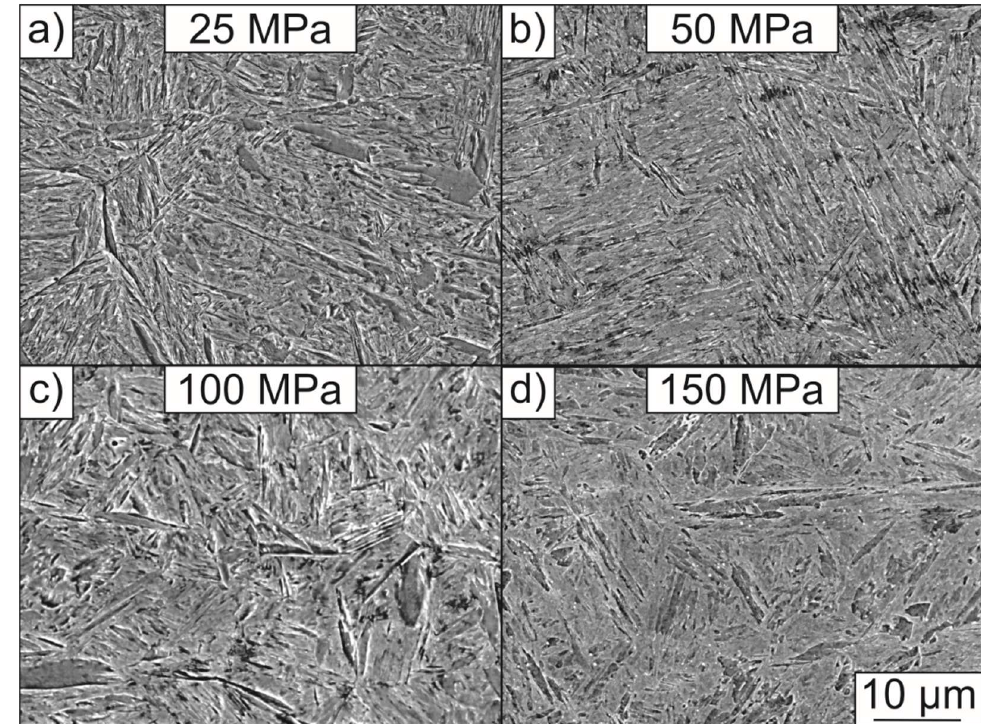
Figure 6. Martensitic microstructure after integrated HIP heat treatment of X37CrMoV5-1 wire material resulting from different processing pressures and corresponding cooling rates in quenching mode (URQ).